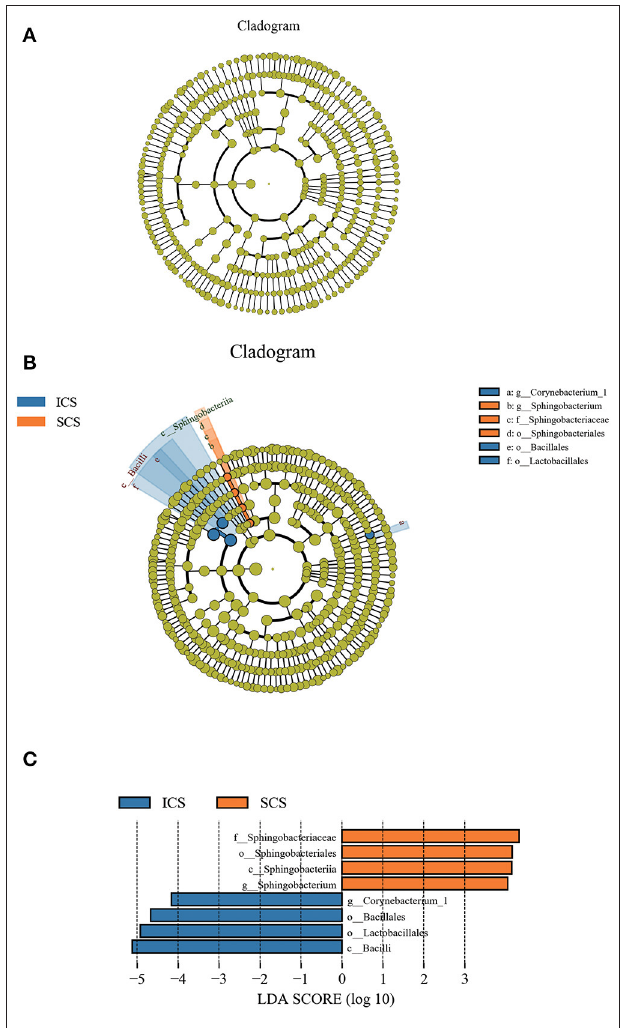
FIGURE 7 | Differential bacterial abundance analyzed by linear discriminant analysis effect size (LEfSe). (A) Colonies with different abundances after treatment for 7 days. Our results showed no difference in abundance between the two groups. (B,C) Colonies with different abundances after treatment for 14 days, Sphingobacterium increased after treatment with SCS, and abundances of Corynebacterium_1 (genus level), Bacillales (order level), and Lactobacillales (order level) were decreased by ICS treatment ( p <